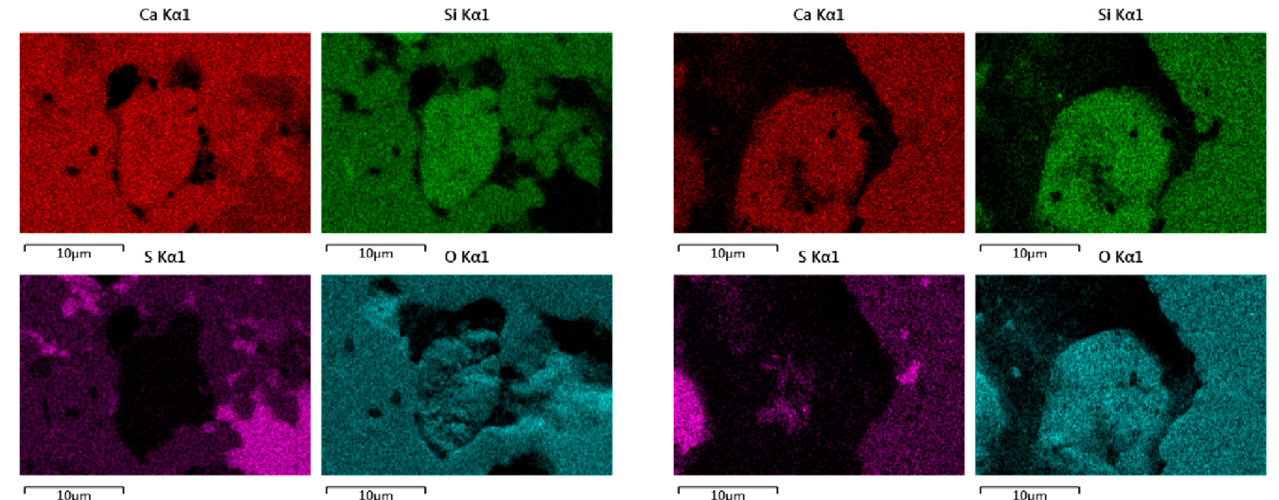
Figure 10. BSE images of the areas of interest: ( a ) is the raw mixture of β -C 2 S and CaSO 4 ∙ 2H 2 O, ( b ) is sample treated at 1100 °C for 0 h. All embedding maps for EDS analysis represent the spectra of the marked points in the images. The black area represents the portion of the pore filled with epoxy resin. BSE images of the areas of interest: ( c ) is sample treated at 1100 °C for 1 h, ( d ) is sample treated at 1100 °C for 12 h. All embedding maps for EDS analysis represent the spectra of the marked spots in the images. The black area represents the portion of the pore filled with epoxy resin.